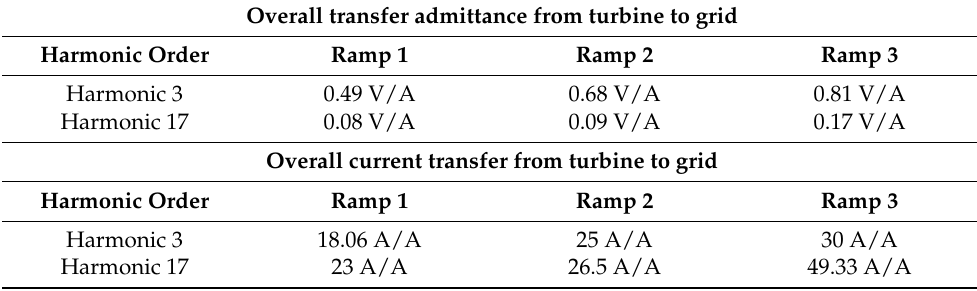
Table 1. Summary of the different transfer functions for selected harmonic